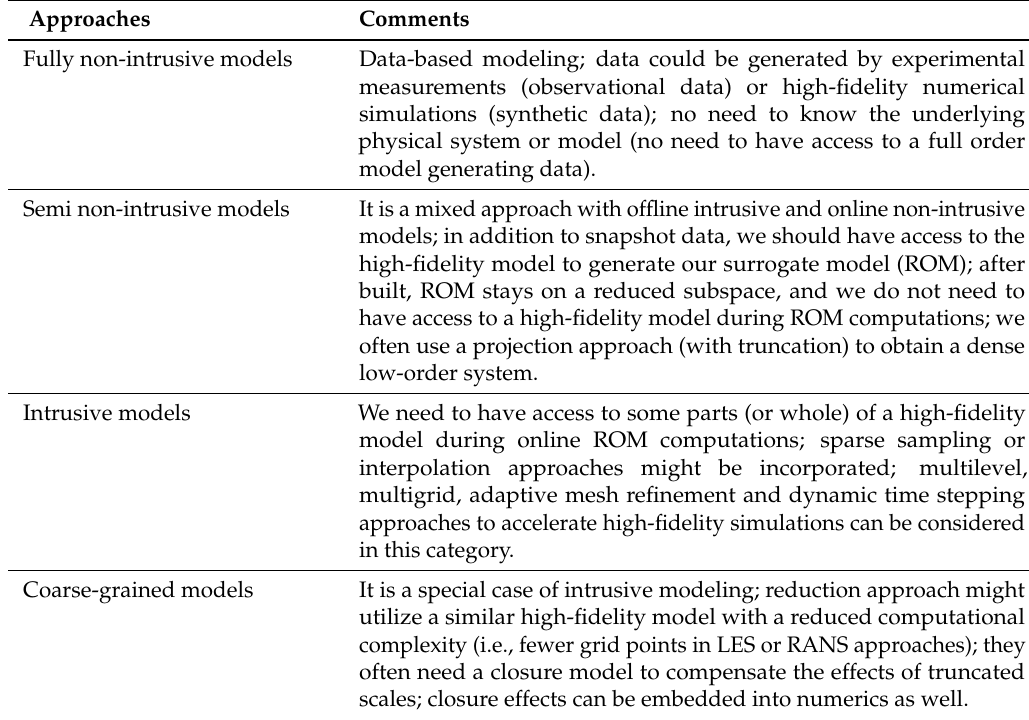
Table 1. A classification of reduced-order modeling